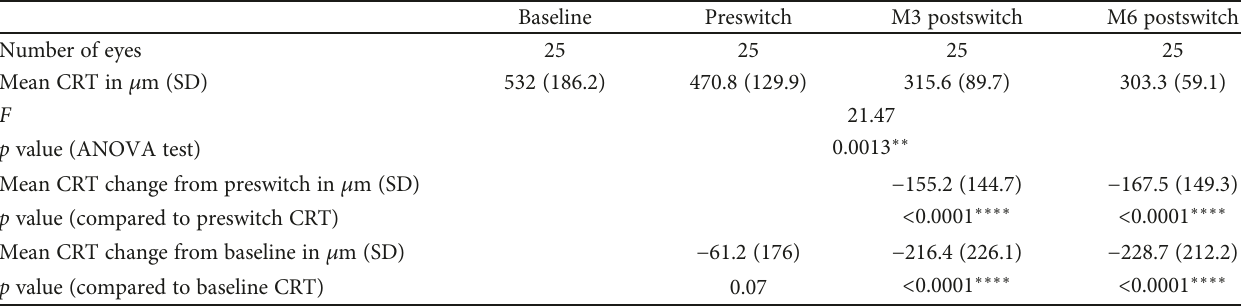
Table 3: Anatomical outcomes: central retinal thickness before any intravitreal injection (baseline) and before and after switch to a fl ibercept at M3 and